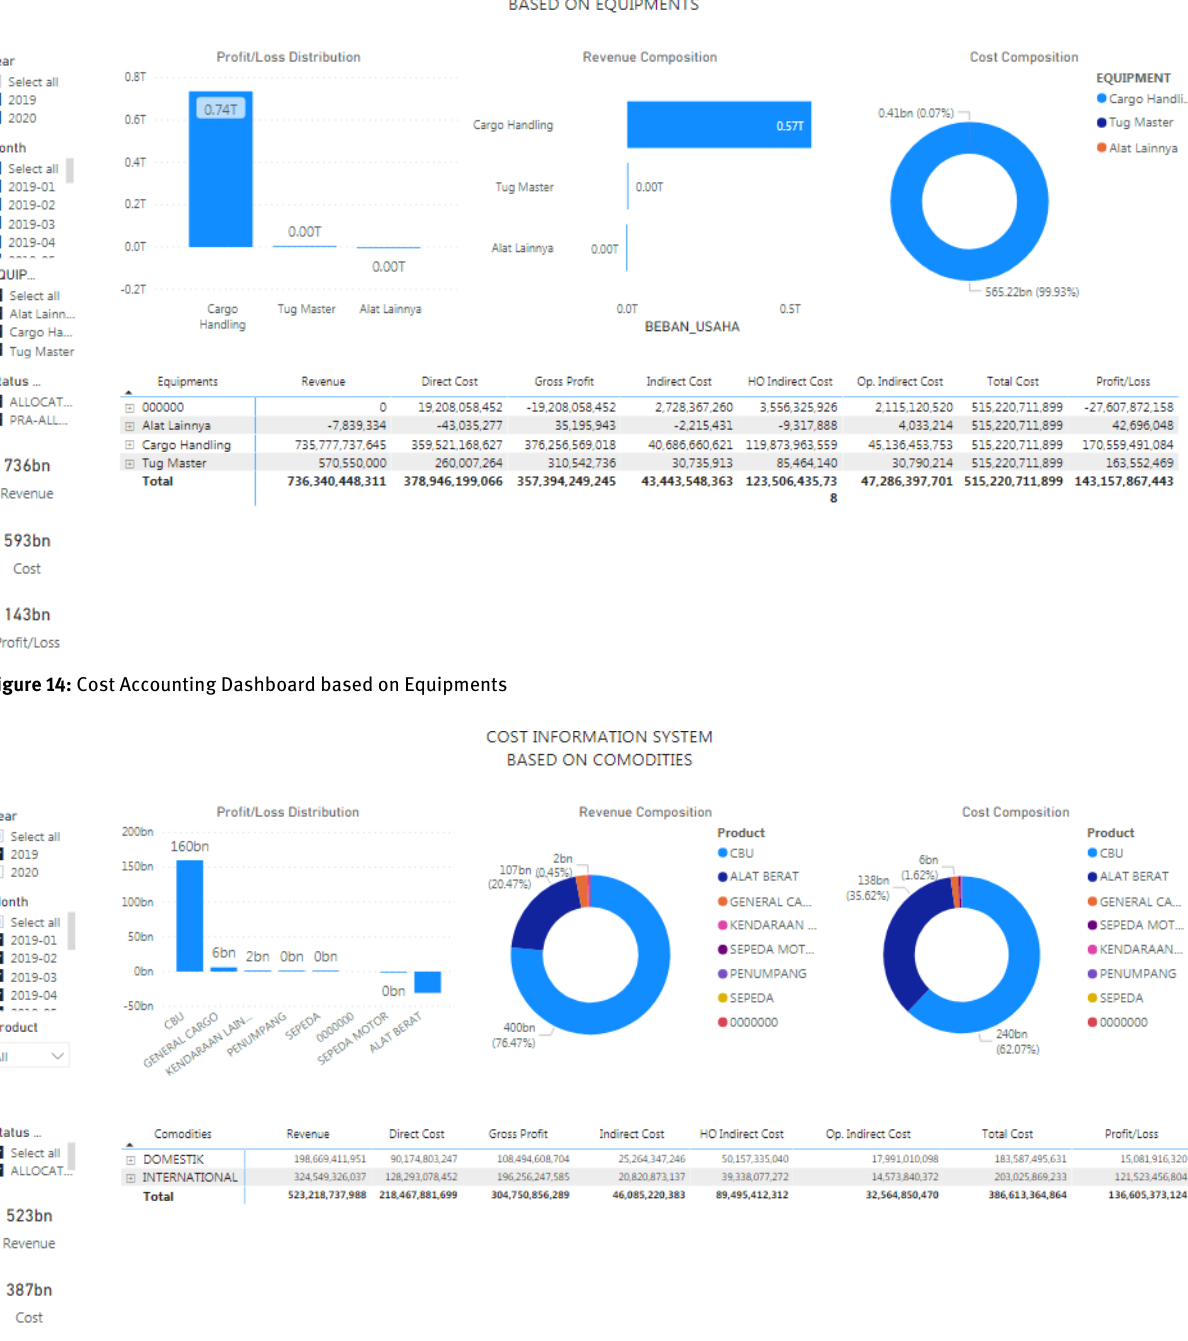
can be seen by customer group so that the revenue gener- ated and costs incurred from each customer can be evalu-